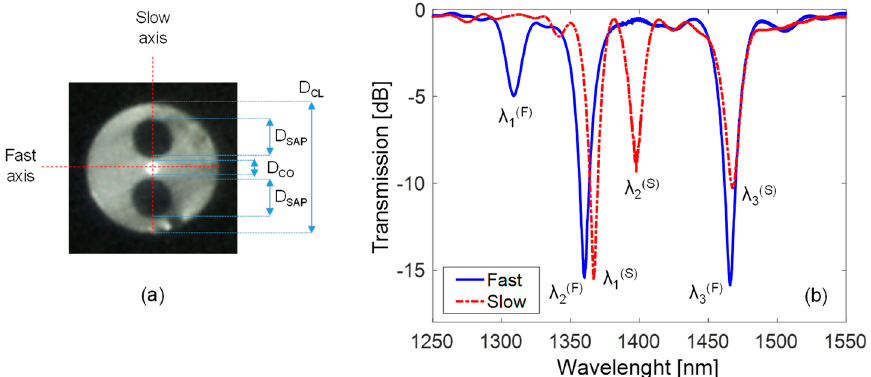
Figure 5. ( a ) Transverse section of Panda type polarization-maintaining fiber (PMF) model PM1300-XP; ( b ) Transmission spectra of arc-induced LPG in the fiber for fast and slow axis polarization.